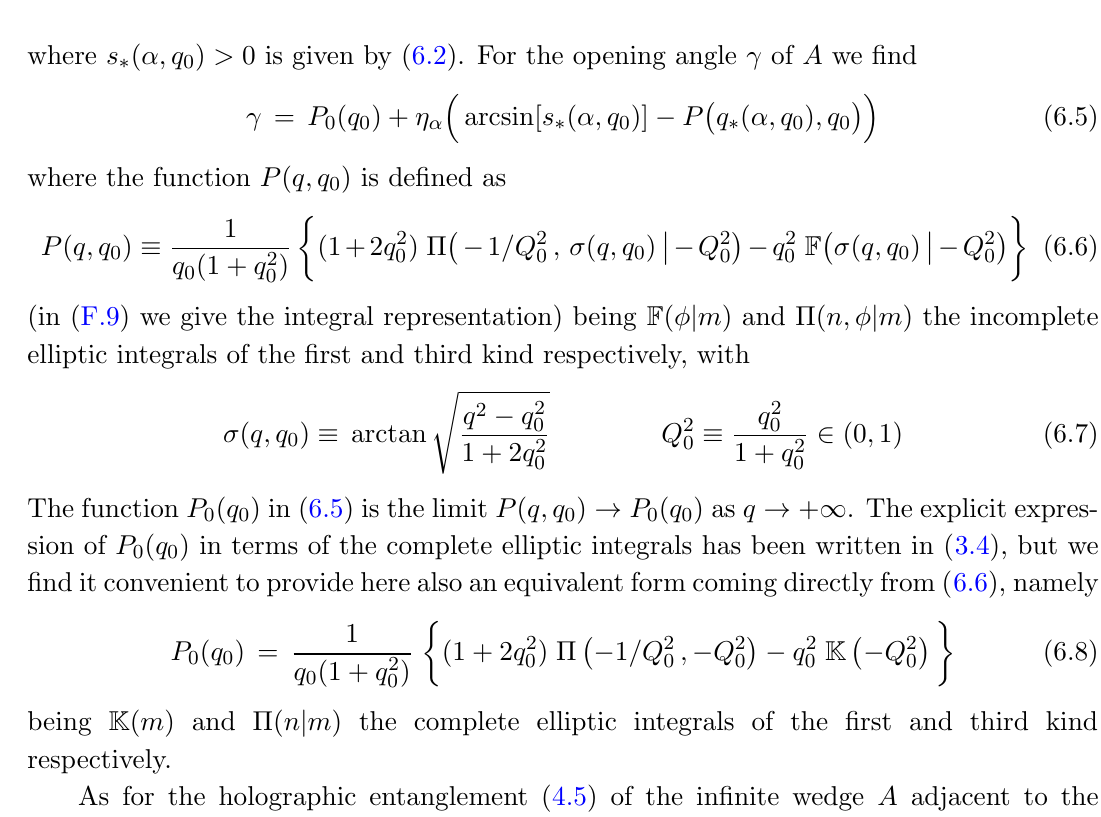
Figure 12 . Minimal surfaces ^ (cid:13) A obtained with Surface Evolver corresponding to a region A given by the intersection between the grey half plane at z = 0 and a disk of radius R whose center has coordinate x > 0. The entangling curve @A \ @B (red line) is an arc of circumference. The green half plane is Q de(cid:12)ned by (4.3) and the green curve corresponds to ^ (cid:13) A \ Q . In the (cid:12)gure " = 0 : 03, R = 1 and the center of the disk has coordinate x = 0 : 6. In the left panel (cid:11) = (cid:25)= 3, while in the right panel (cid:11) = 2 (cid:25)= 3. The numerical data of the corner function F (cid:11) ( (cid:13) ) corresponding to this kind of domains are labeled by empty circles in (cid:12)gure